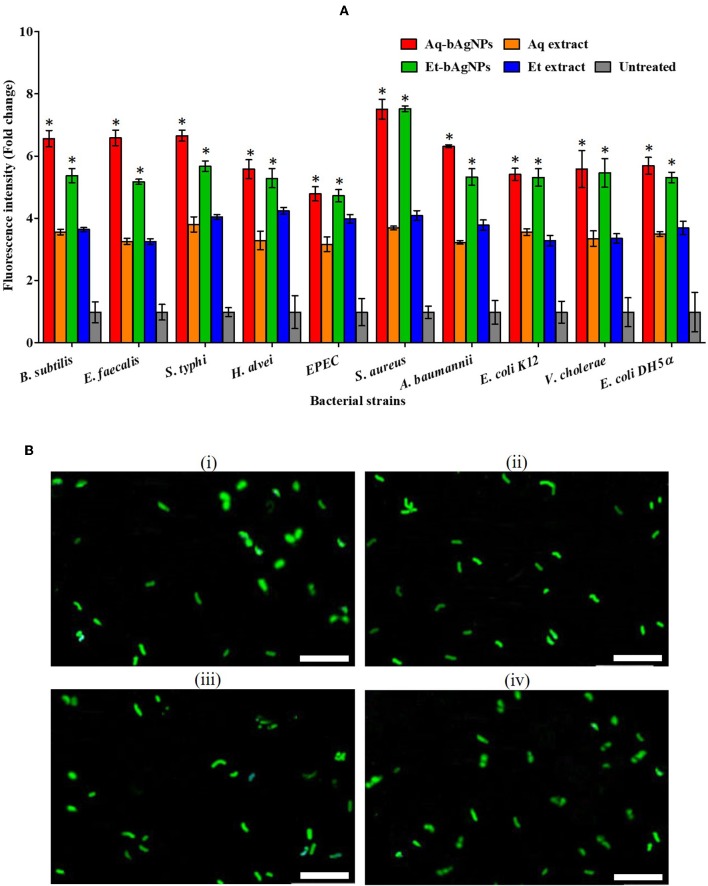
(A) CellToxTM Green uptake assay. The fluorescence intensity of bacteria treated with Aq-bAgNPs and Et-bAgNPs was measured at 490 nm using a spectrofluorometer. The values presented are mean ± SE of multiple samples (n = 3). Data were analyzed using one-way ANOVA followed by Tukey's multiple comparison test. The fluorescence intensity of both bAgNP-treated bacteria was significantly higher than that of the plant extract treated as well as untreated bacteria and *P < 0.05. (B) CellToxTM Green uptake assay. B. subtilis was first treated with Aq-bAgNPs (i) and Et-bAgNPs (ii). The treated bacteria were then incubated with CellToxTM green to stain the cell wall compromised bacterial DNA, and green fluorescence was observed under a fluorescence microscope. The same experiment was also performed for E. faecalis after treating them with Aq-bAgNPs (iii) and Et-bAgNPs (iv). Scale bar: 20 μm.